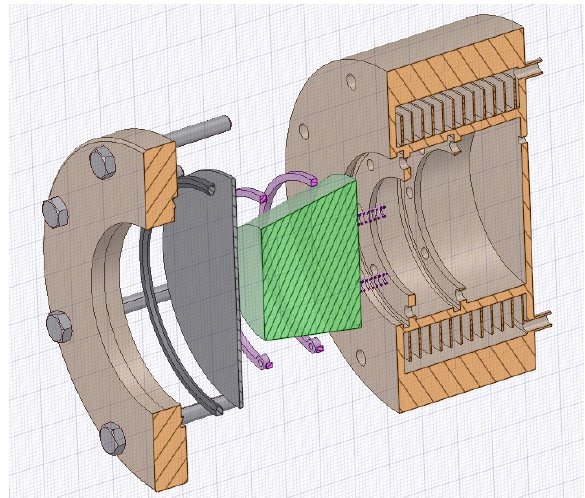
Fig. 6. Exploded view of the CoolGAL ANSYS model. The finned outer surface of the cladding and a matching copper outer layer define a cooling circuit. The surface of the cladding in contact with the coolant (flowing water) has cooling fins. Forced air cooling is not viable.